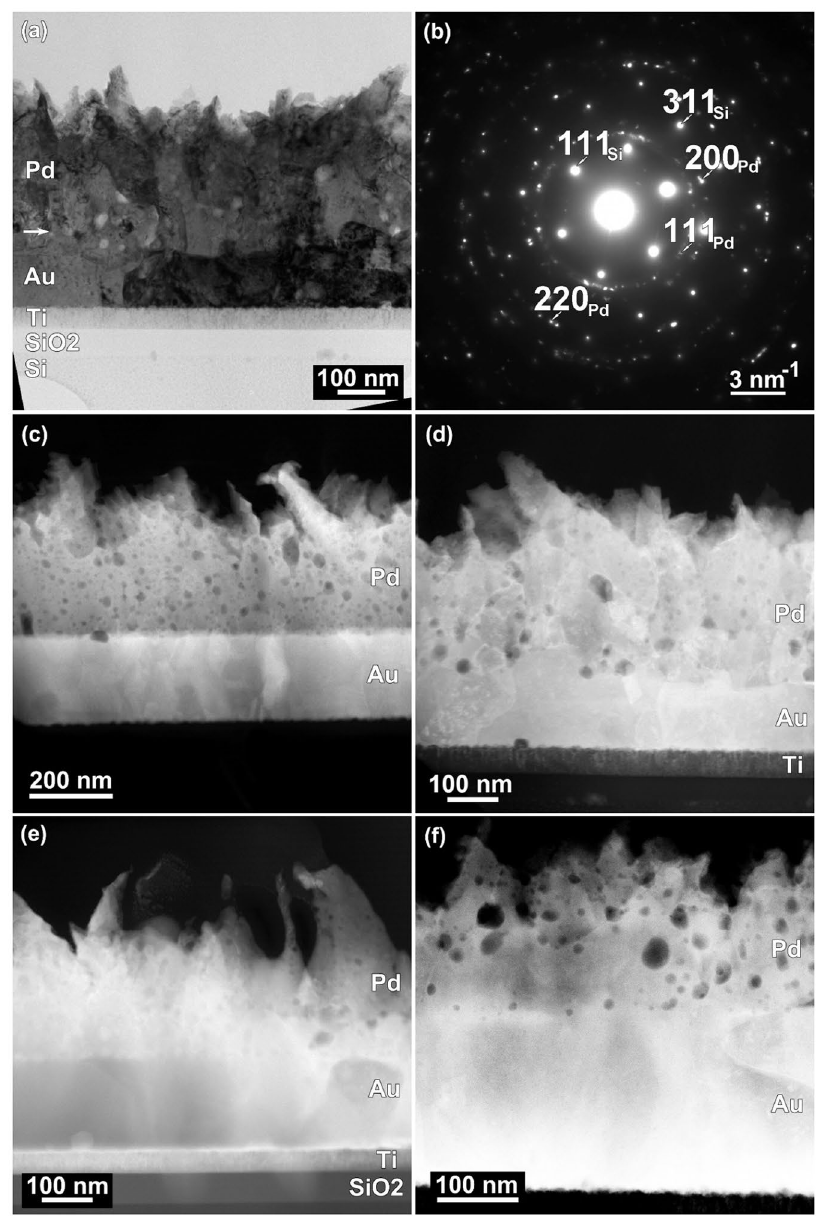
Figure 3. ( a ) TEM image at low-magnification of PdO/Pd/Au/Ti/SiO2/Si electrodes. ( b ) SAED pattern corresponding to TEM image ( a ). ( c , f ) HAADF-STEM images at low-magnification showing the morphology of Pd layers in PdO/Pd/Au/Ti/SiO 2 /Si electrodes after: ( c ) EC deposition, ( d ) thermal, ( e ) basic and ( f ) acid